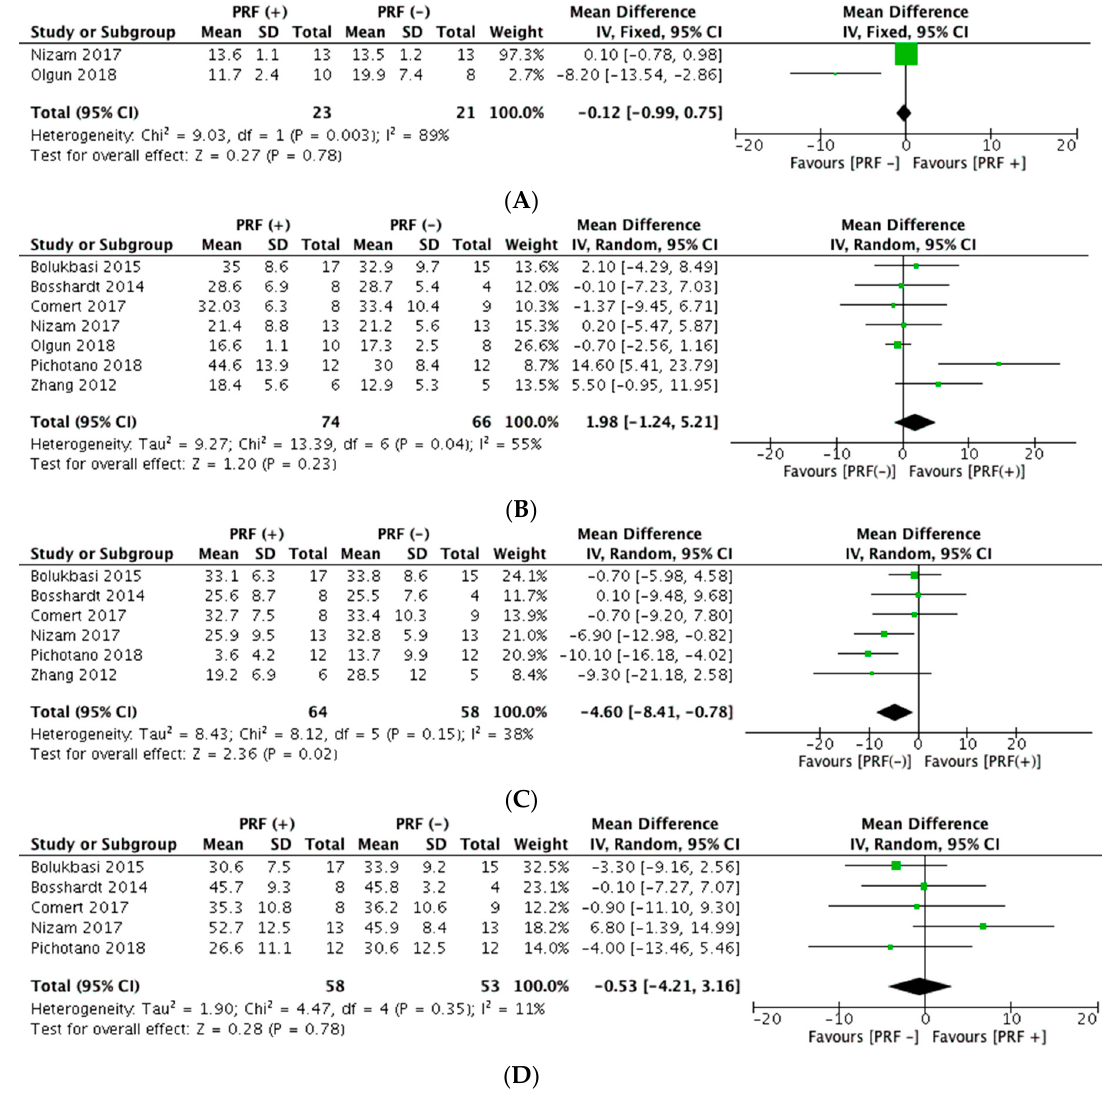
Figure 2. Plot for comparison: PRF and grafting biomaterial in sinus floor augmentation. ( A ) Augmented bone height (mm), ( B ) Percentage of new bone formation, ( C ) Percentage of residual bone-substitute material, and ( D ) Percentage of soft-tissue area.